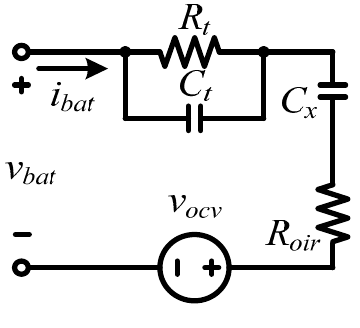
Figure 1. PNGV battery model.